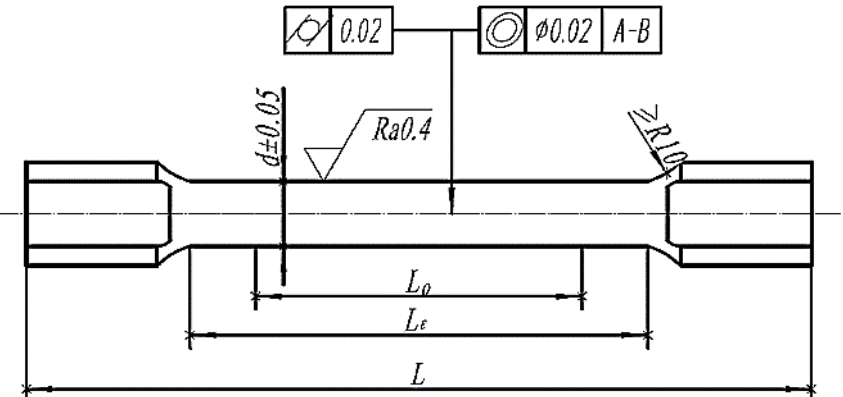
Figure 1. Cylindrical tensile specimen.